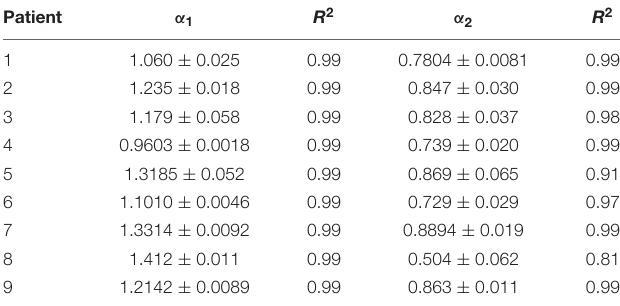
TABLE 5 | Estimated values of short-term ( α 1 ) and long-term ( α 2 ) scaling exponents in the fourth cluster of heart failure patients.